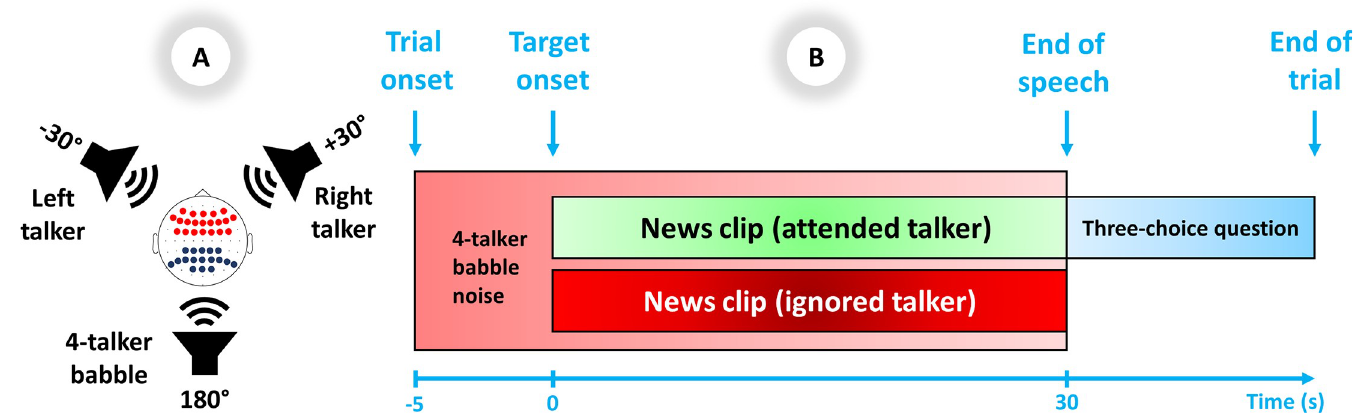
Fig 1. A) Spatial setup of the experiment: Test subjects attended to target stimuli from a front loudspeaker ± 30˚ to the left or right. The contralateral front loudspeaker presented the talker to be ignored. The rear loudspeaker presented 4-talker babble. In the superior view of the head, EEG electrode locations for frontal theta are shown in red dots and parietal alpha are shown in dark blue dots. B) Trial scheme: The target and distractor speech were presented 5 seconds after the onset of the 4-talker babble and then continued for 30 seconds, followed by a three-choice question regarding the content of the attended target audio